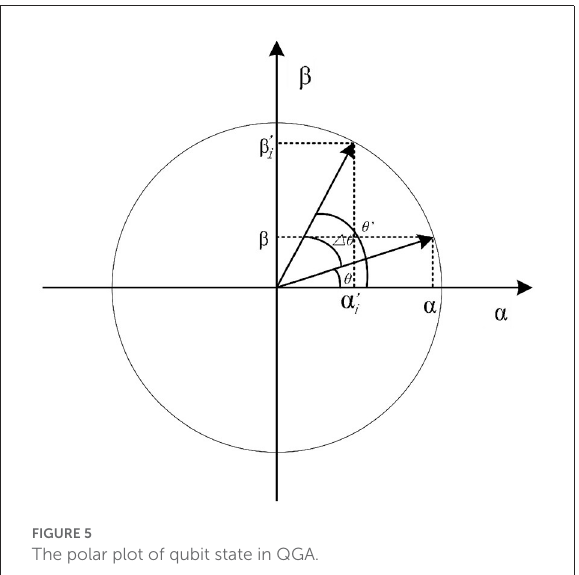
FIGURE5 The polar plot of qubit state in QGA.